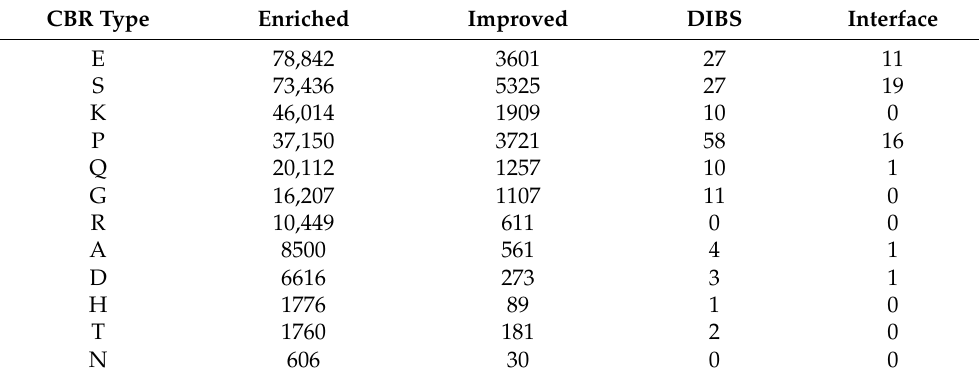
Table 2. IDR-CBRs in protein hubs and their interaction interfaces. Columns indicate: CBR type, how many interactors with this particular type of IDR-CBRs were found (i) enriched in sets of interactors of hub proteins, (ii) of those how many were in sets whose enrichment improved when selecting higher quality interactions, (iii) of those how many were present in an entry considering their interaction with the hub protein in the DIB database, and (iv) of those in how many the enriched IDR-CBR overlapped with the defined region interacting with the hub protein. Details are available in Supplementary Files S2 and